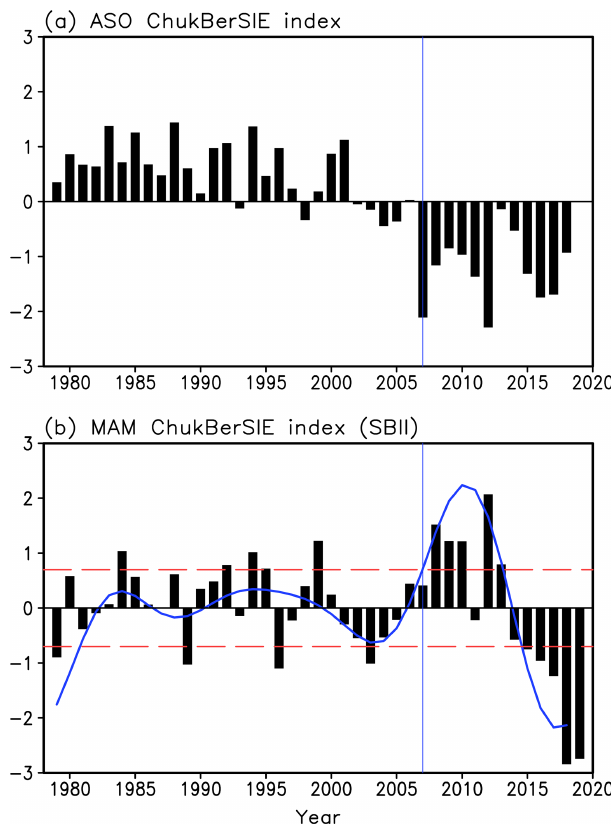
Figure 2. (a) Normalized summer (August–October mean) Chuk- BerSIE index. (b) Normalized spring (March–May mean) Chuk- BerSIE index (SBII, black bars), superposed by its decadal com- ponent (blue lines). Red dashed lines mark the threshold of ± 0 . 7 standard deviation for selecting the composite years. The vertical blue line indicates the critical year of 2007.